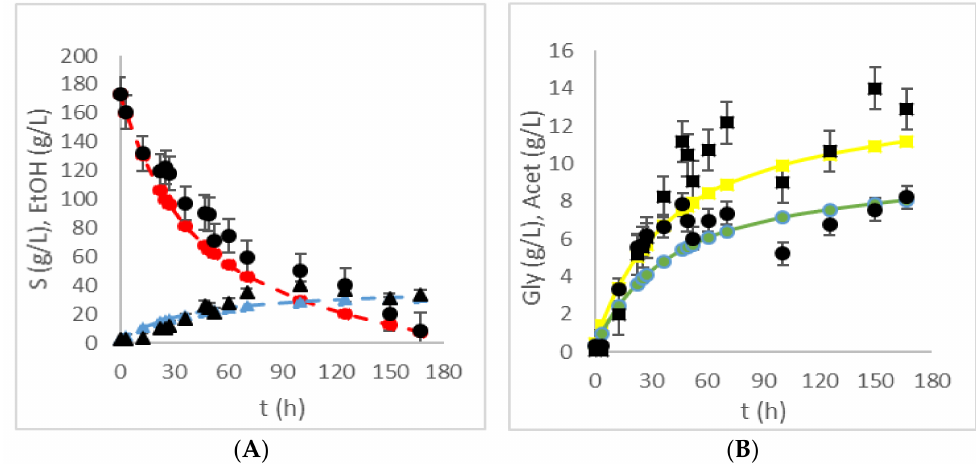
Figure 1. Comparison between experimental (no line) and model values (dashed line) for ( A ) substrate ( • ) and ethanol ( (cid:78) ) concentration and ( B ) glycerol ( (cid:4) ) and acetic acid ( • ) concentration obtained for experiment with constant HRTB rotation mode (10 rpm). Discrepancies between experimental data are presented as error bars. An example of bioethanol production in the HRTB at interval rotation mode (12 min;